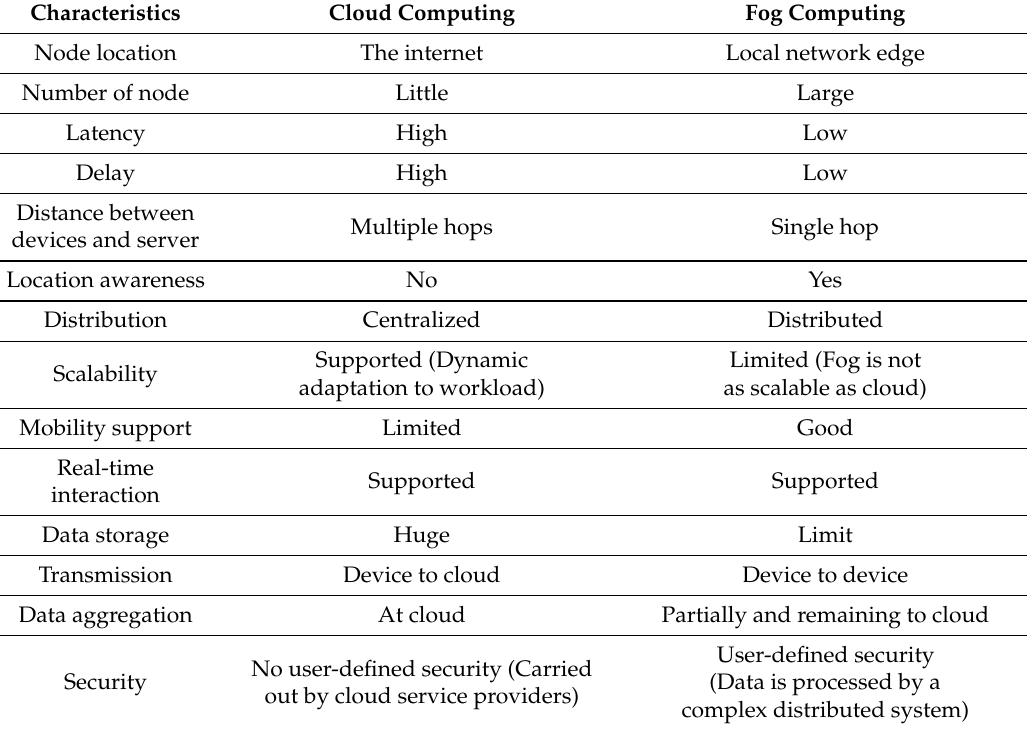
Table 4. Comparison of several characteristics of cloud computing and fog